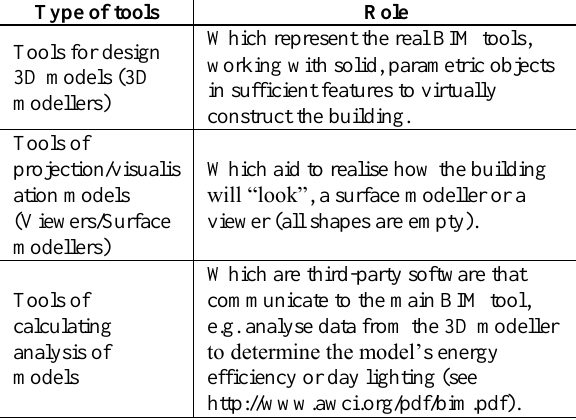
Table 2. Types of BIM platforms